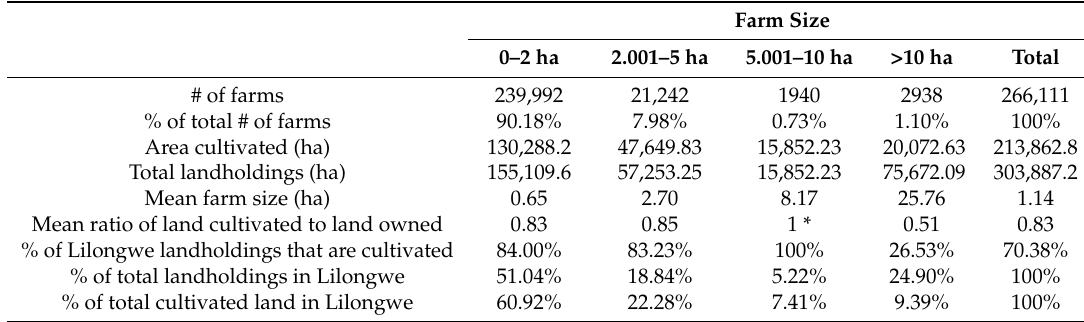
Table A2. Landholdings and area cultivated, by farm size in Lilongwe district. Source: [27].